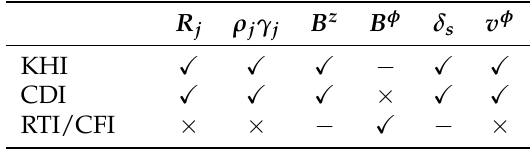
Table 1. Summary of the stabilizing/destabilizing factors for each of the most relevant/studied instabilities in relativistic jets so far. A (cid:88) symbol indicates a stabilizing effect and × indicates a destabilizing effect as the parameter grows. From left to right, the parameters are: jet radius (expansion), jet inertia, poloidal field, toroidal field, shear-layer width, and toroidal velocity. The − sign indicates that there is no effect or that it is ambiguous, depending on factors like radial distribution. The table only pretends to give general and orientative trends but different radial distributions or combinations can change the trends given (see the